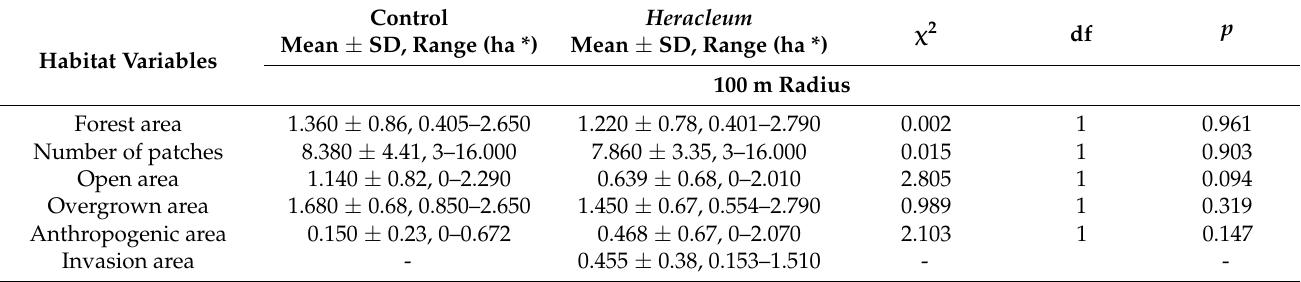
Table A2. Differences in the area of habitat variables between control and Heracleum sites (in a